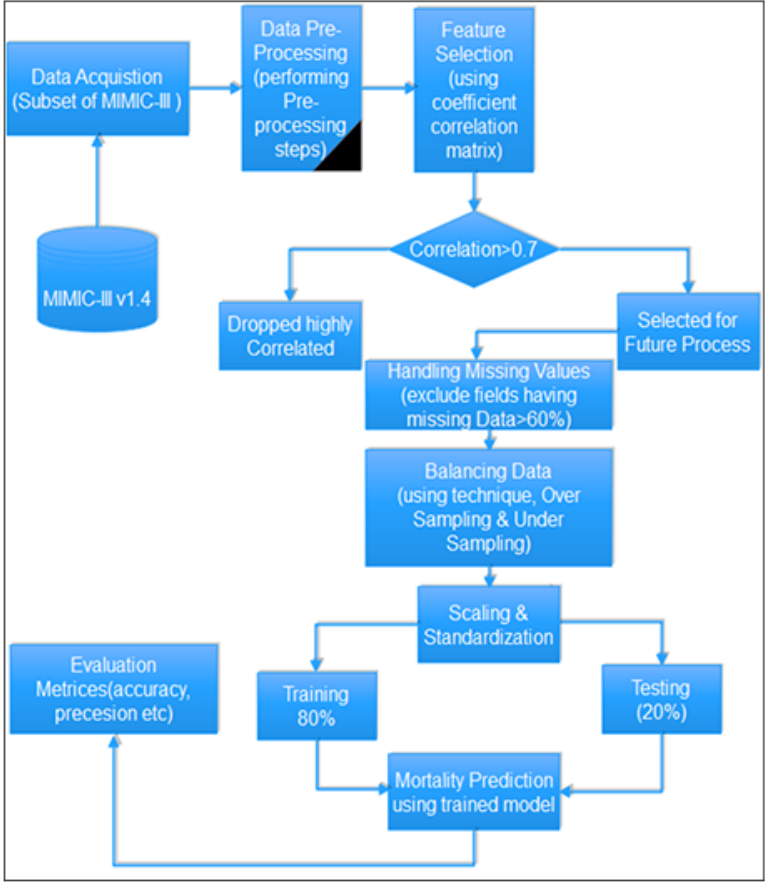
Figure 3. Flow of features selection process.